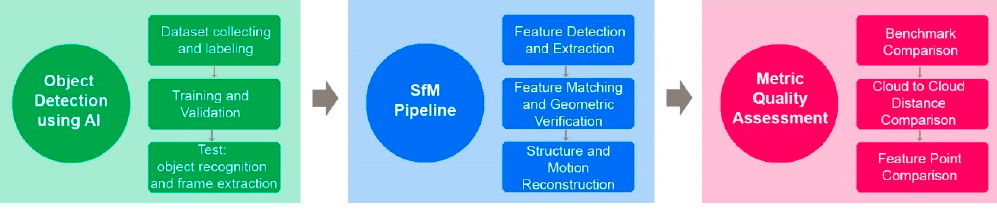
Figure 1. Flowchart of the proposed workflow.